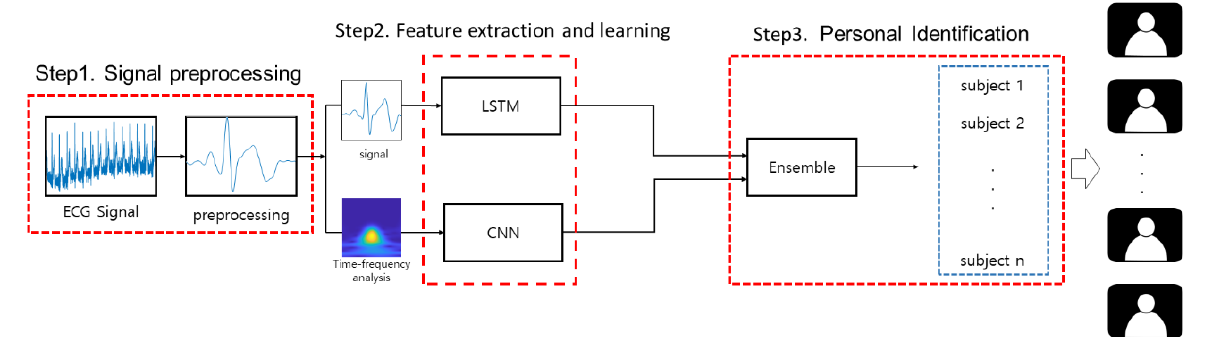
Figure 15. Flowchart of proposed ensemble-based personal identification.